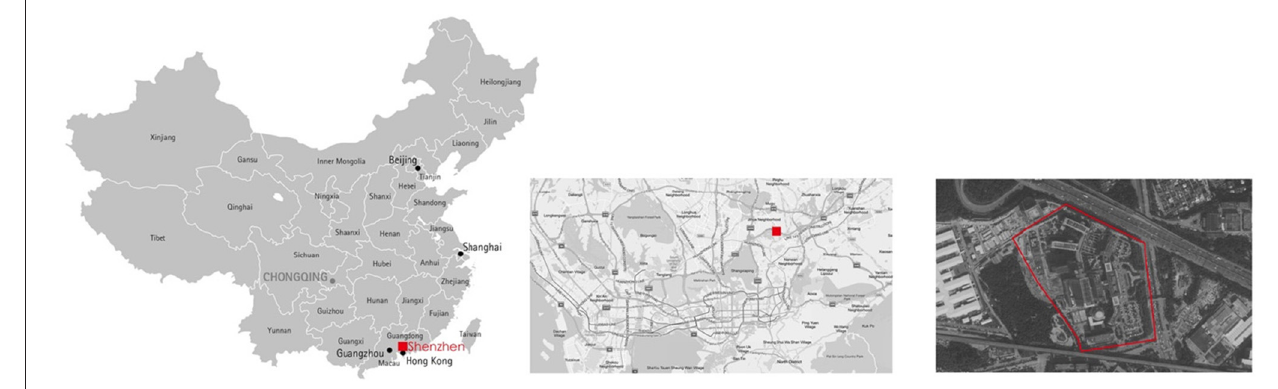
FIGURE 2 | The location of the Shenzhen Third People Hospital.